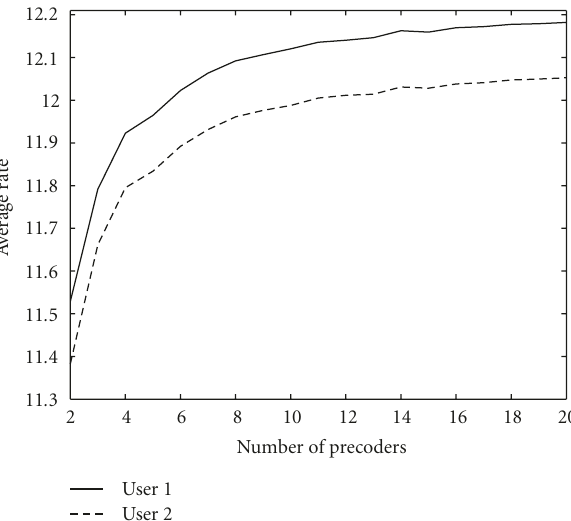
Figure 14: Achieved average rate versus codebook